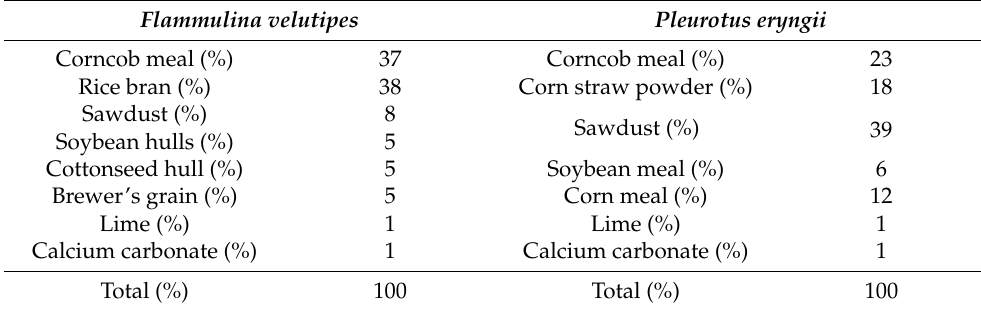
Table 1. Percentage of raw material in spent mushroom substrates. Flammulina velutipes Pleurotus eryngii Corncob meal (%) 37 Corncob meal (%) 23 Rice bran (%) 38 Corn straw powder (%) 18 Sawdust (%) 8 Sawdust (%) 39 Soybean hulls (%)